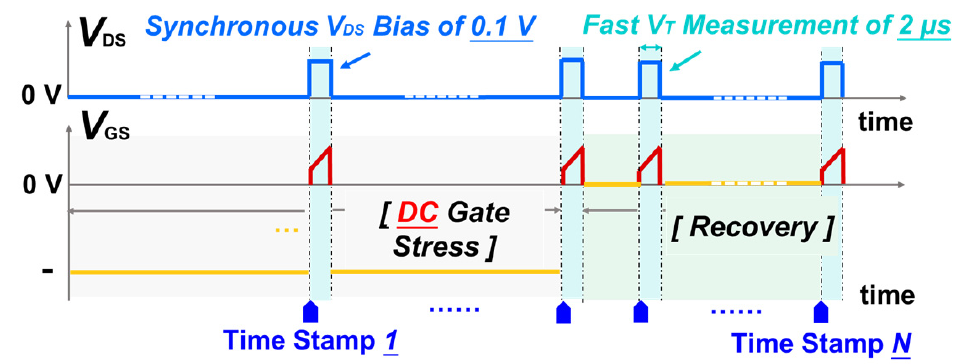
Figure 3. Schematics of an MSM sequence for transient ∆ V T characterization in stress and recovery processes under negative DC gate stress.